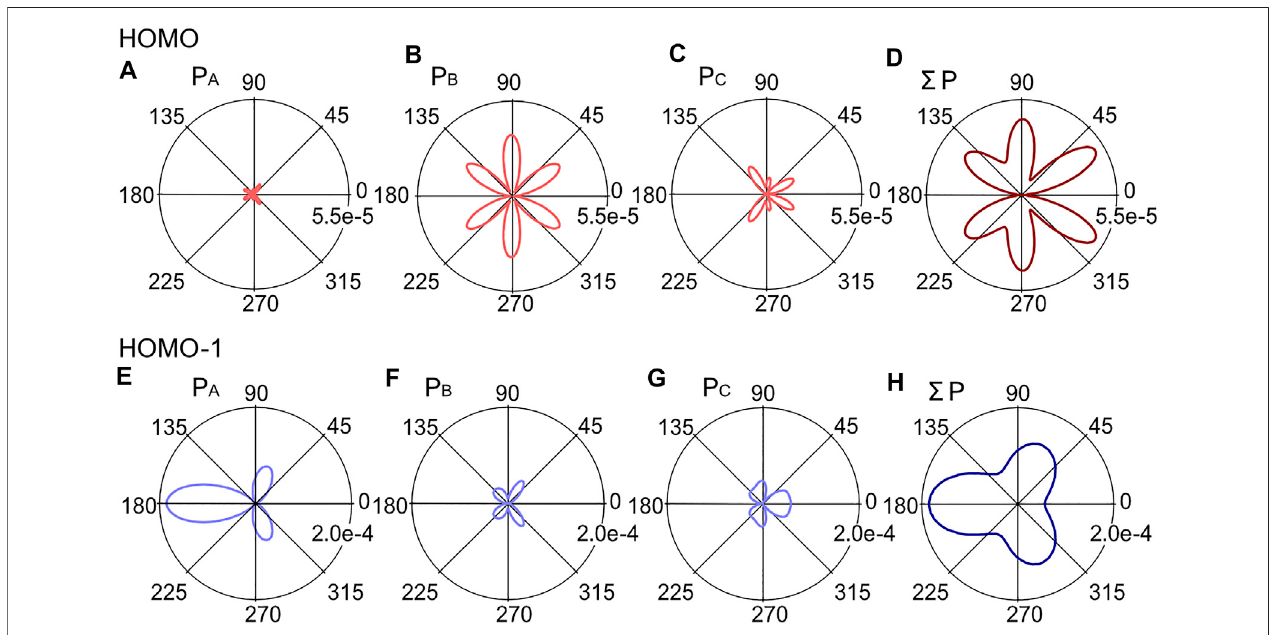
FIGURE 8 | Angular distributions P ( θ s ) calculated for the eigenorbitals, ϕ A , ϕ B , and ϕ C , in the ω -2 ω laser fi eld with the relative phase ϕ = 0, (A) P A ( θ s ), (B) P B ( θ s ), (C) P C ( θ s ), and (D) the sum Σ P ( θ s ) for HOMO and (E) P A ( θ s ), (F) P B ( θ s ), (G) P C ( θ s ) and (H) Σ P ( θ s ), for HOMO-1. Note the difference in the scaling of the polar plots for HOMO and HOMO-1.